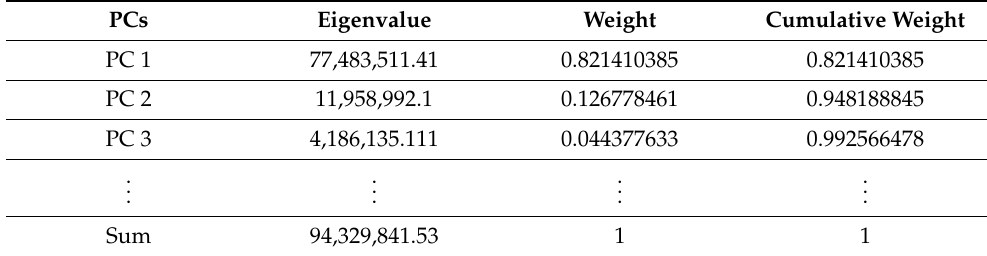
Figure 5. Hyperion band (B045); original versus predicted gray scale ( a ) with their histograms ( b ). Table 2. Principal component